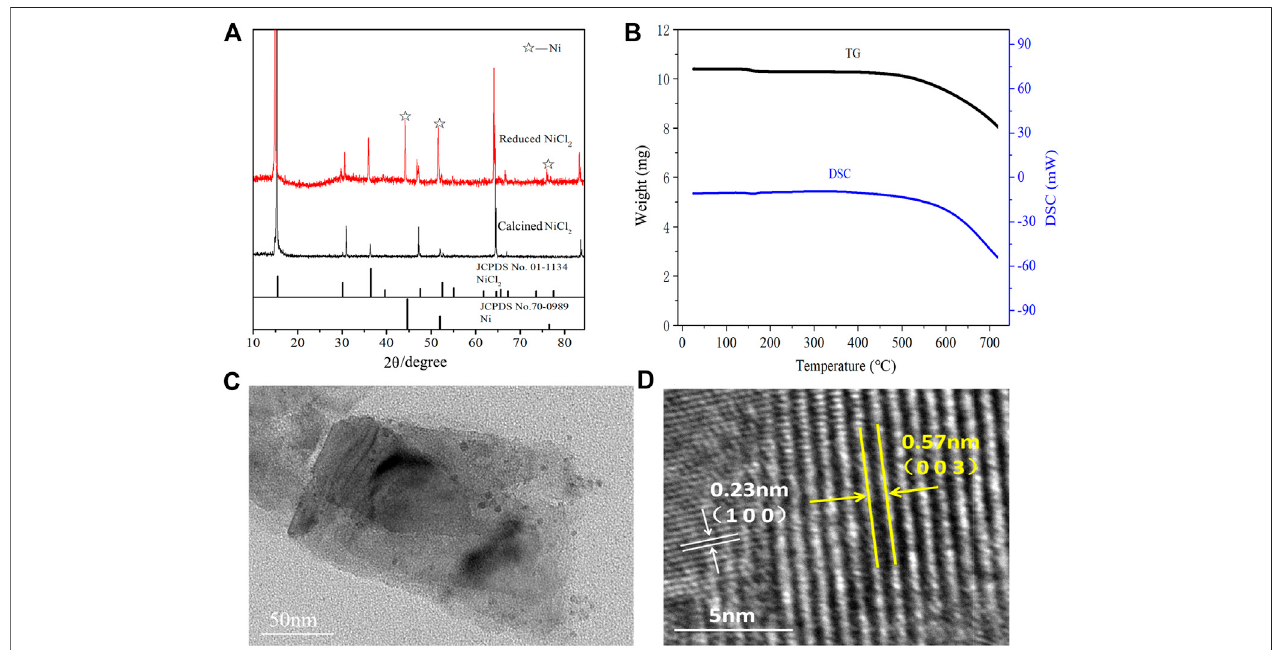
FIGURE 4 | (A) XRD patterns of calcinedand reduced NiCl 2 , (B) thermal analysis curves of calcinedNiCl 2 , and (C) TEM and (D) HRTEM images of the Ni-NiCl 2 composite materials.